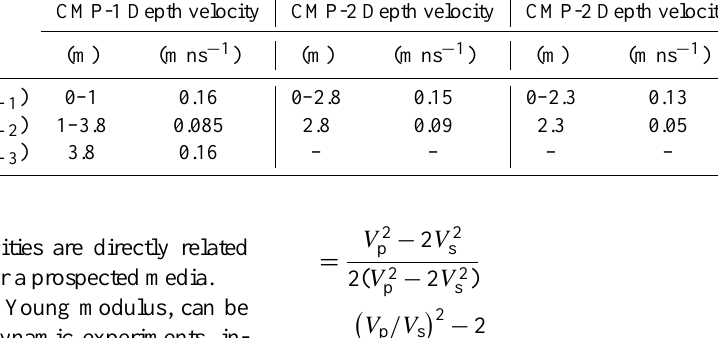
Figure 7. Distribution of mechanical parameters obtained from modeling of the P- and S-wave (SR Method): (a) spatial model of Bulk module; (b) spatial model of shear modulus; (c) spatial model of Young’s modulus; (d) model spatial of Poisson constant. Table 2. Velocities obtained from the CMP data.